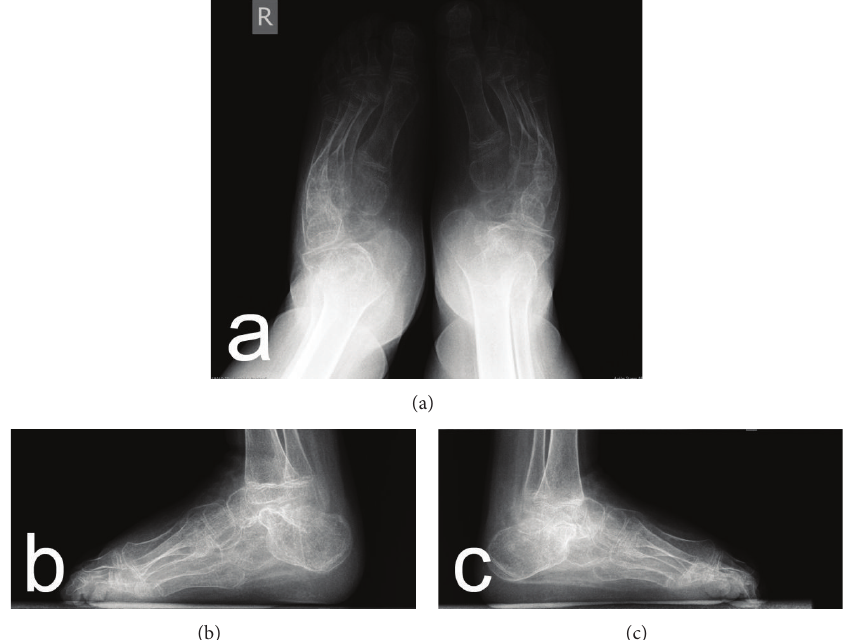
Figure 4: Postoperative anteroposterior (a) and lateral (b, c) radiographs of the patient (brother) with hereditary motor and sensory neuropathy type I.